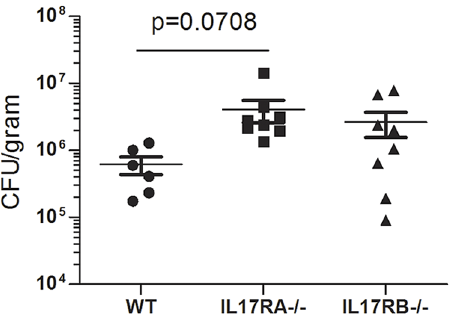
Figure 2. Colonization of IL-17RB deficient mice with H.pylori . IL-17RA 2 / 2 mice, IL-17RB 2 / 2 mice and WT mice were infected with H. pylori strain SS1. Levels of colonization were measured by plating serial dilutions of stomach homogenates. The number of colony forming units (CFU) was then calibrated to the weight of the tissue and CFU/ gram is presented on the graphs for 3 months post-infection.